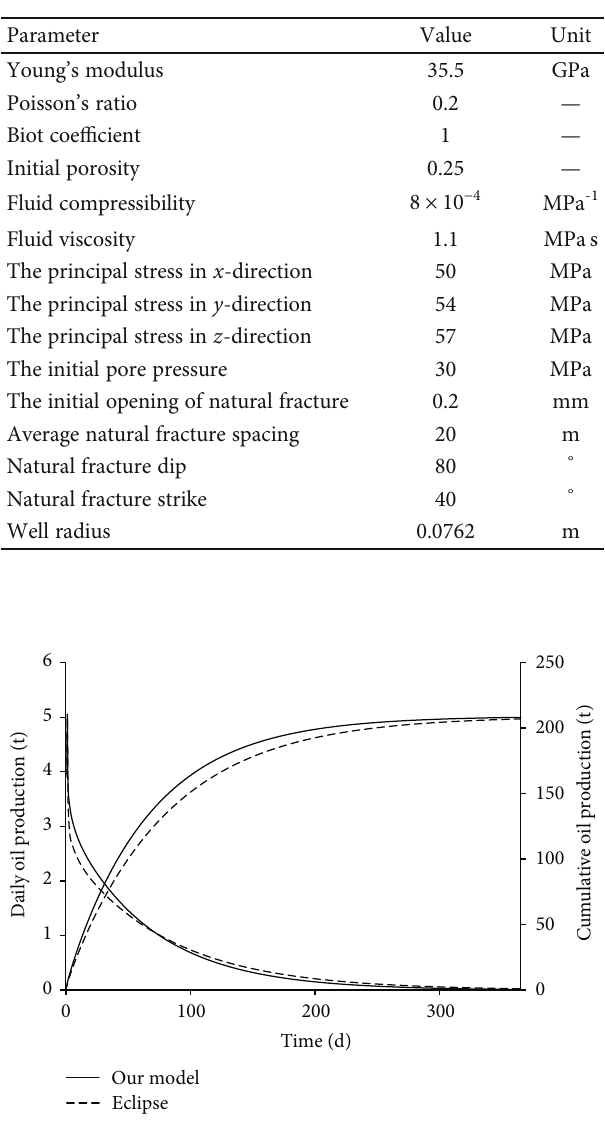
Table 1: Primary parameters of calculation.